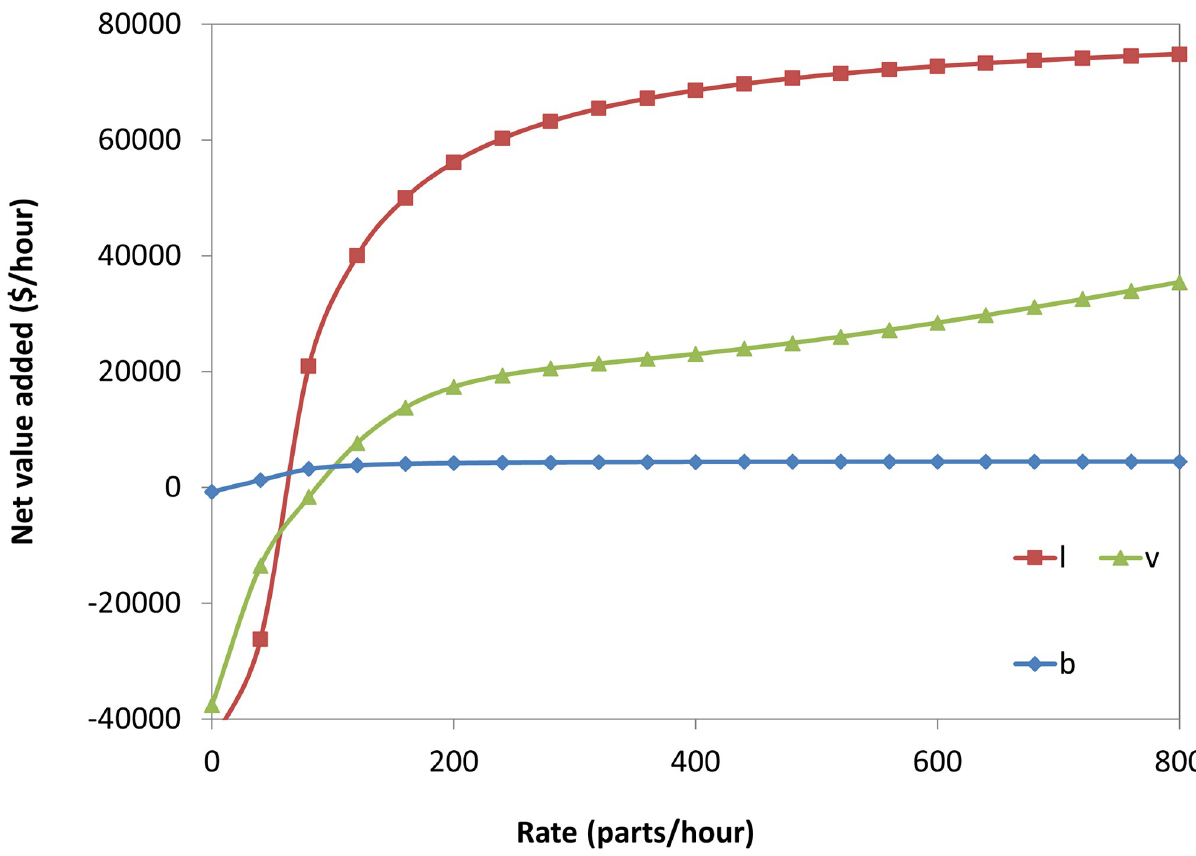
Fig 22. The net value added for a triple-machine FMC versus the system